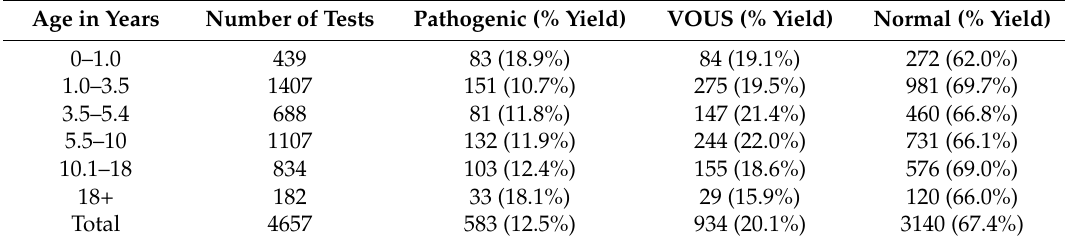
Table 4. Diagnostic yield by age in patients without autism spectrum disorder (ASD) (1750 (37.6%) females, 2907 (62.4%) males, Total n = 4657).